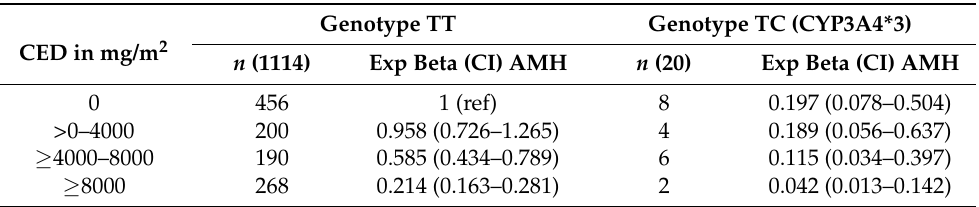
Table 4. Estimated relative AMH levels per genotype of CYP3A4*3 (rs4986910) and CED score based on prevalence in two